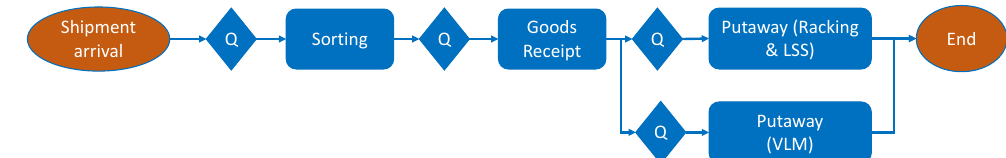
Figure 1. Inbound entity flow